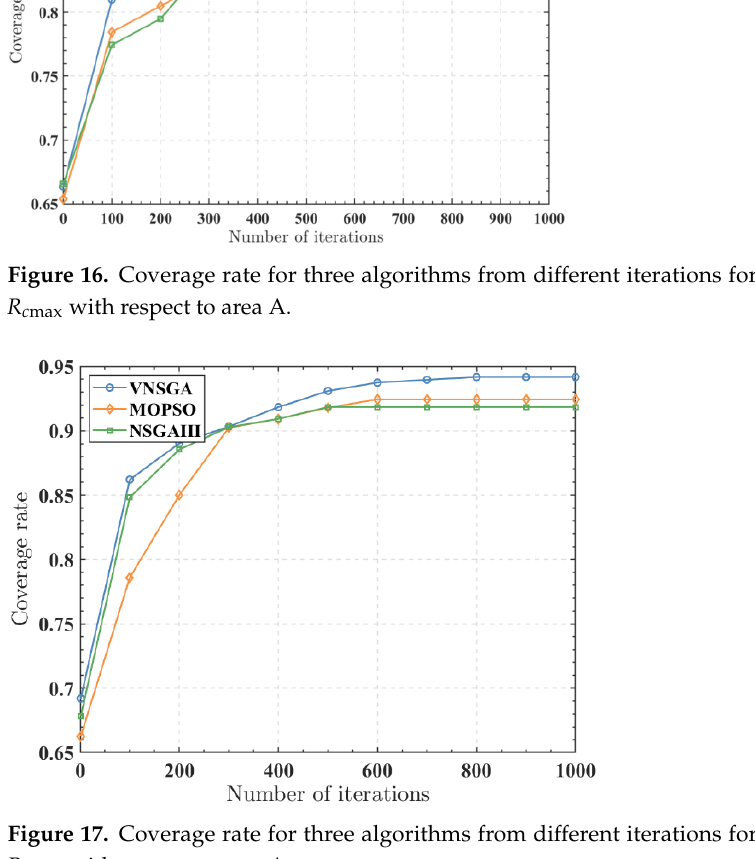
Figure 17. Coverage rate for three algorithms from different iterations for 75 m R s max and 150 m R c max with respect to area A.